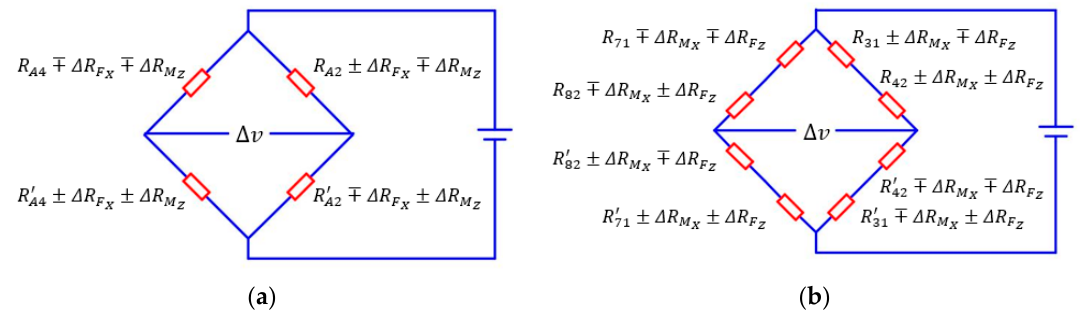
Figure 18. The connection mode of strain gauges in electric bridge: ( a ) the first electric bridge; ( b ) the fourth electric bridge.